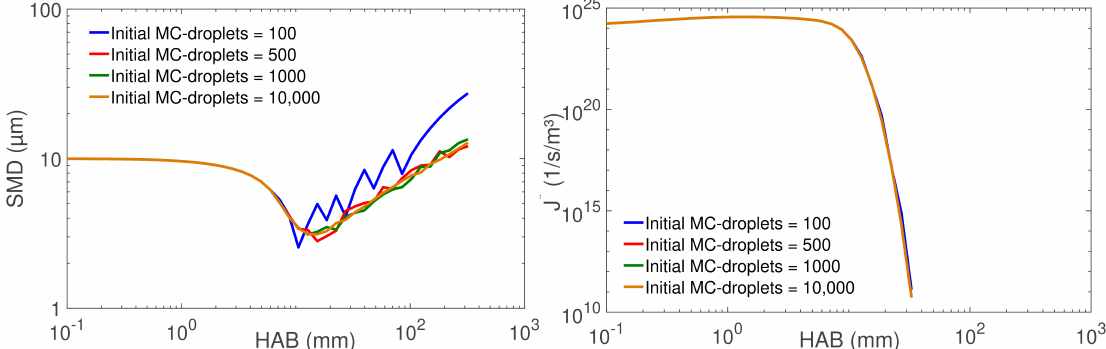
Figure 2. ( Left ) Evaporation noise increases over height above burner (HAB) as the number of Monte Carlo droplets (MC-droplets) decreases due to evaporation; ( right ) the nucleation rate J ∗ is insensitive to evaporation noise if the number of initial MC-droplets is higher than 100.